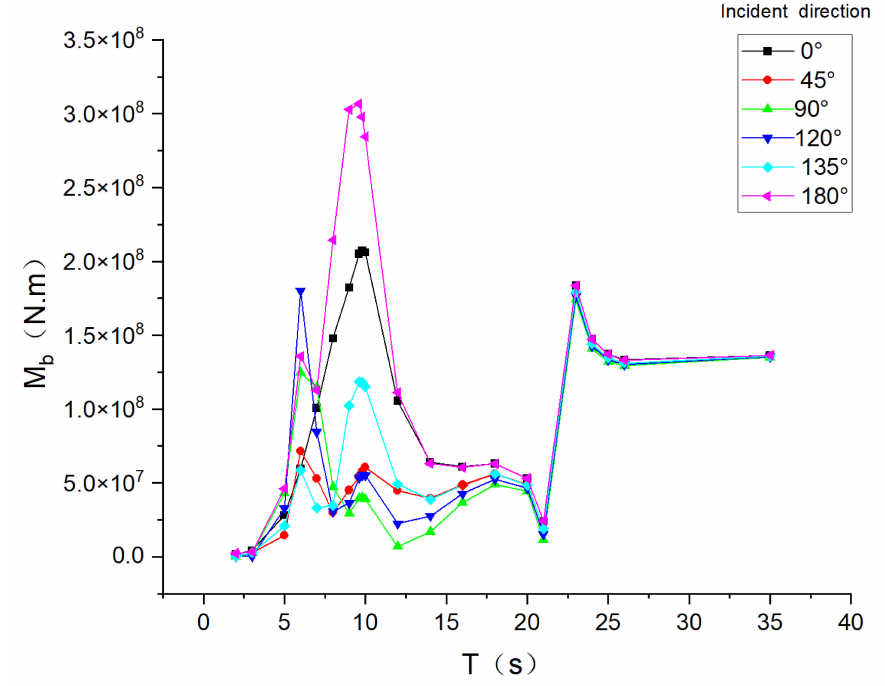
Figure 7. RAO of bending moment.